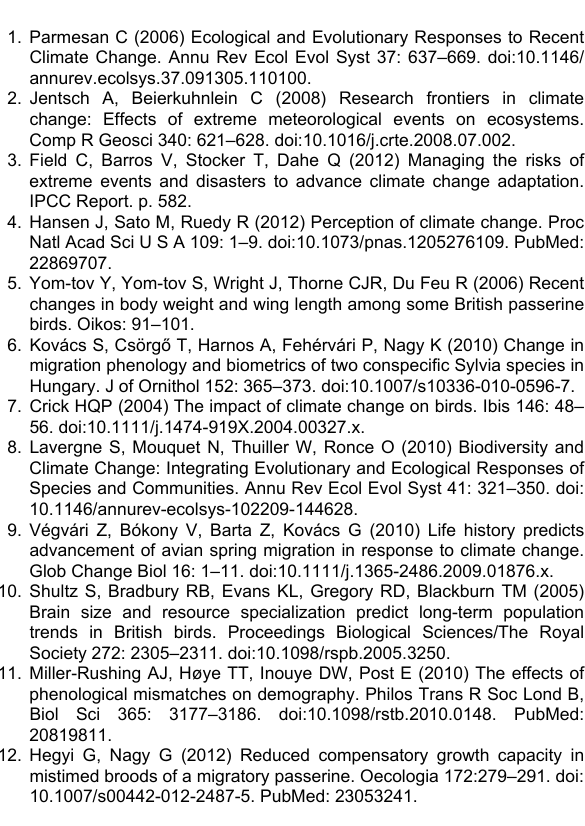
Figure S1. Seasonal change of daily mean temperature (A) and daily amount of precipitation (B) in the study area during house sparrow reproduction. Linear regression line (dashed) and quadratic regression curve (solid) is fitted. (TIF) Table S1. Annual values of reproductive and meteorological parameters in the study population between April-August.